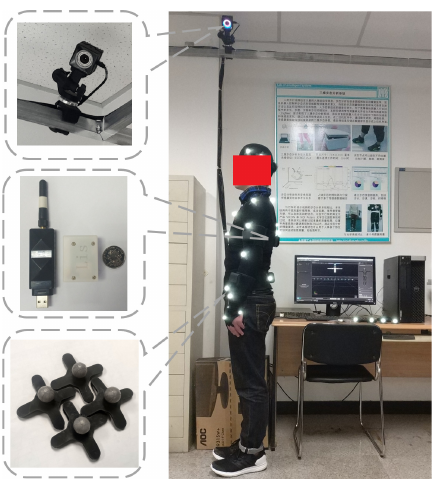
Figure 7. The overview of contrast tests between self-made and standard optical capture